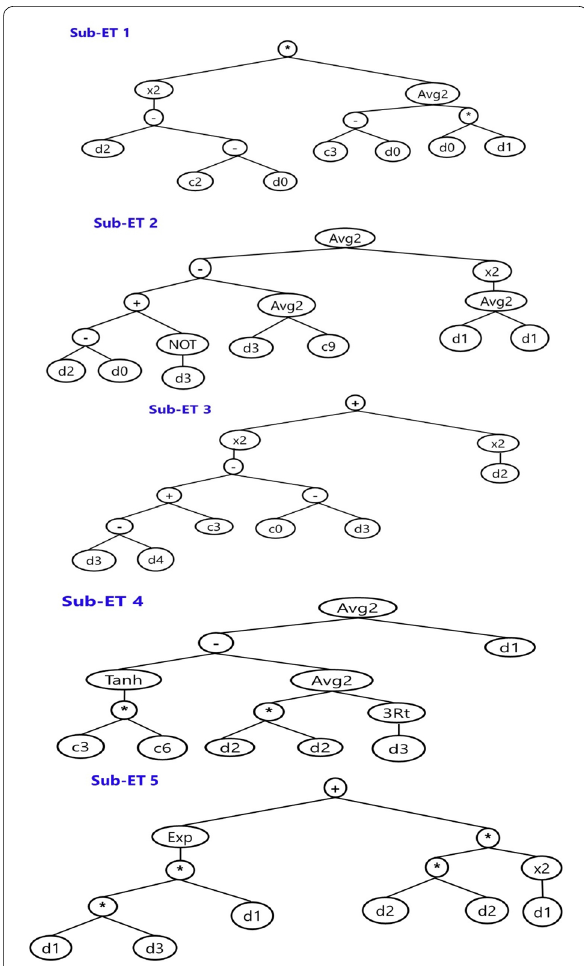
Fig. 5 Expression tree for the